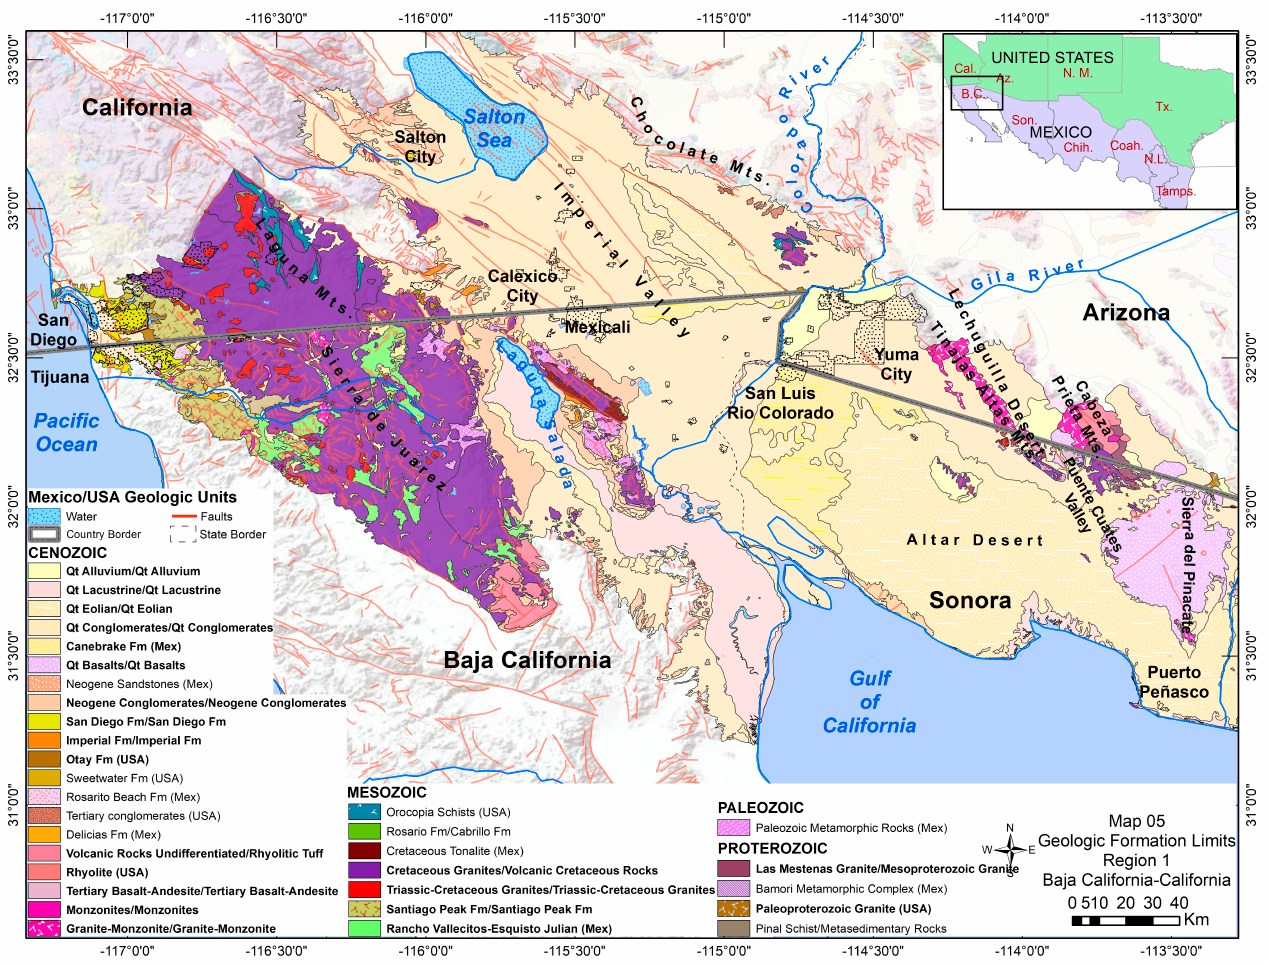
Figure 5. Geologic formation limits, Baja